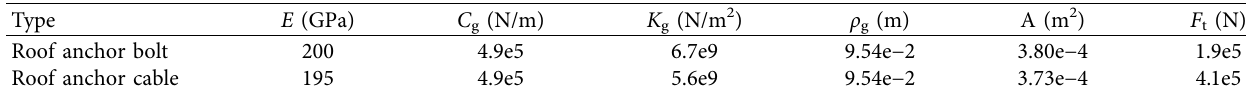
Table 2: Mechanical and geometrical parameters of “Cable” structure element.